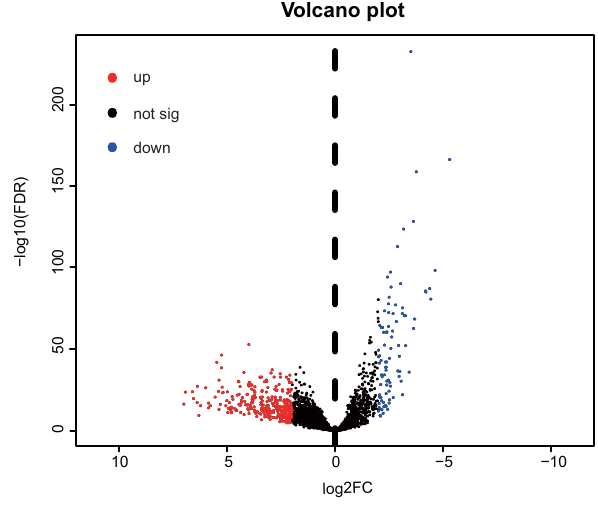
Figure 1: Identi fi cation of 381 di ff erentially expressed lncRNAs. Red dots represent 291 upregulated lncRNAs and blue dots represent 90 downregulated lncRNAs, and the intermediate black dots represent lncRNAs without signi fi cant di ff erences. lncRNA, long non - coding RNA; FC, fold change; sig, signi fi cance; up, upregulated; down, downregulated; FDR, false discovery